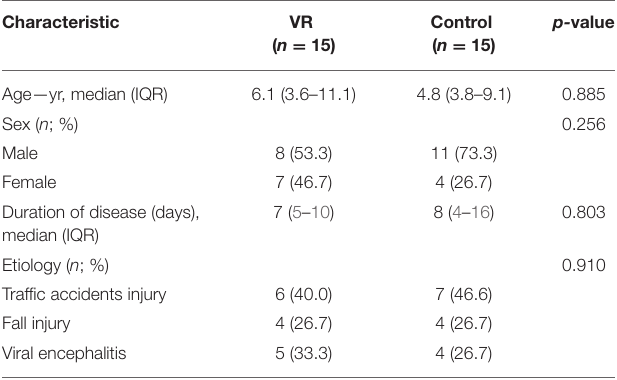
TABLE 1 | Demographic and clinical characteristics at baseline.